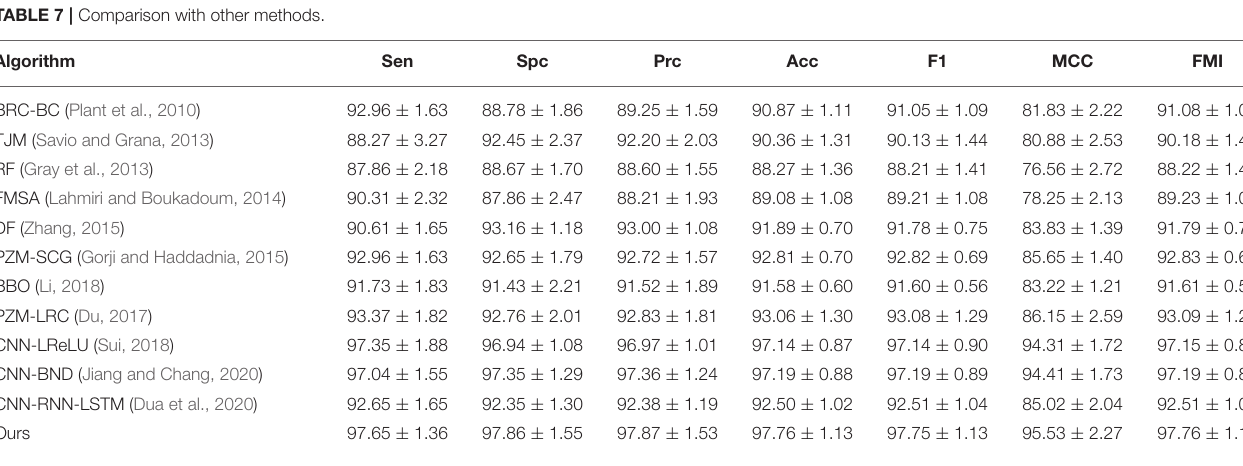
TABLE 7 | Comparison with other